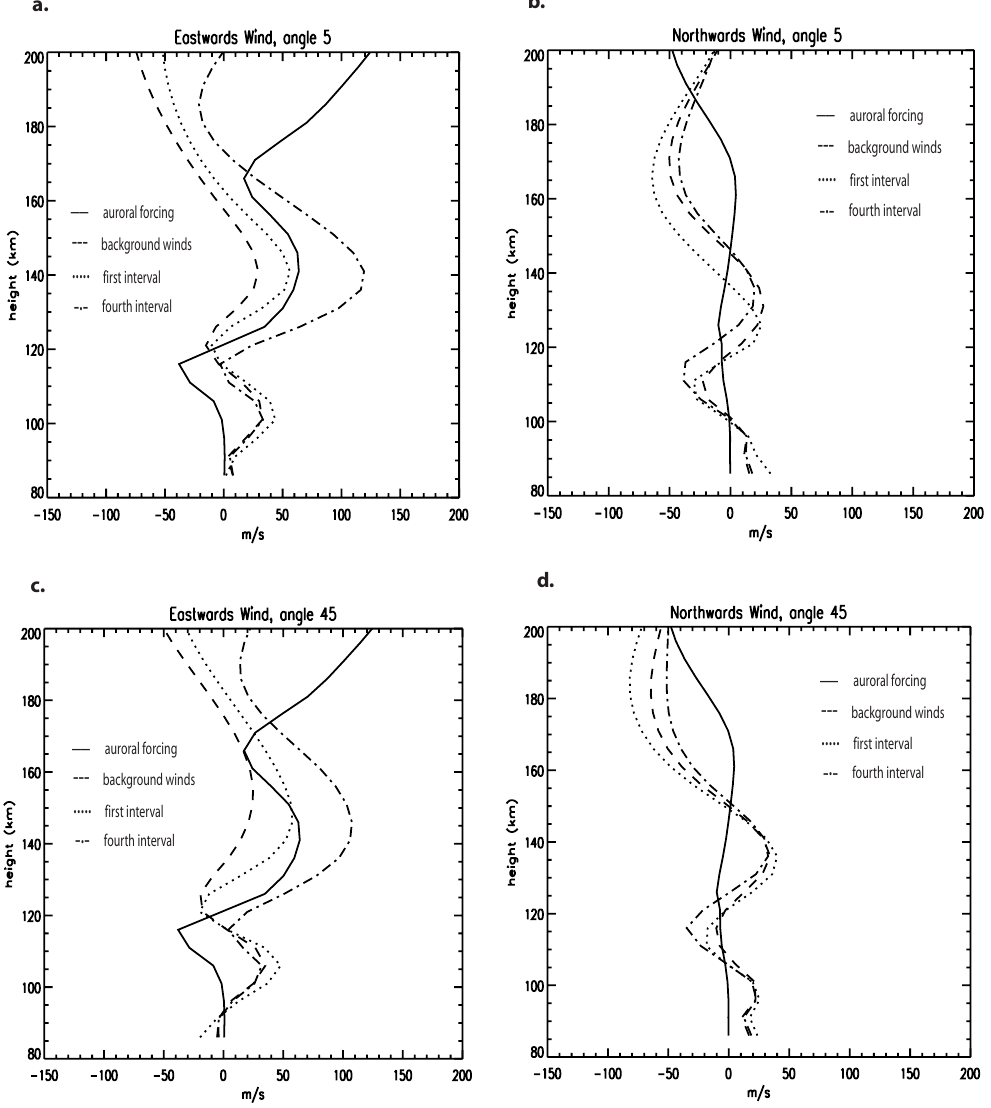
Fig. 9. Response of the neutral winds to different combinations of auroral forcing and background winds and tides, for different angles between the background wind field and the auroral direction (a) , (b) 5deg, (c) , (d)